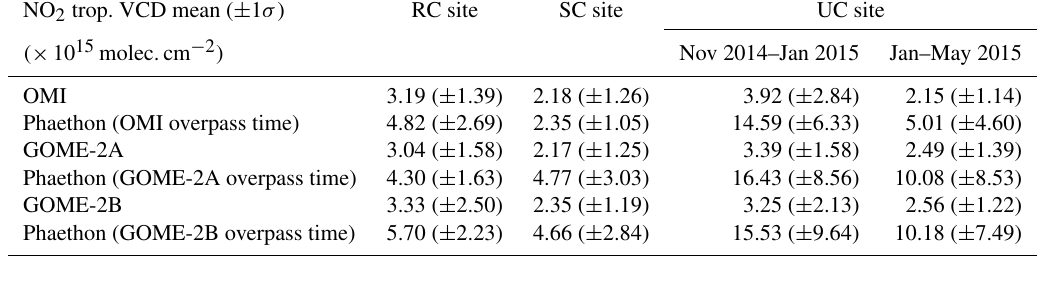
Table 4. Average and standard deviation of space-borne and ground-based tropospheric NO 2 observations over each monitoring site. Phaethon mean values have been calculated from measurements at 15 and 30 ◦ elevation viewing angles (see also Sect. 2.2) within ± 30min of the satellite overpass time. The NO 2 measurements at the UC site are separated into two periods: from November 2014 to end of January 2015 and from mid-January to mid-May 2015.